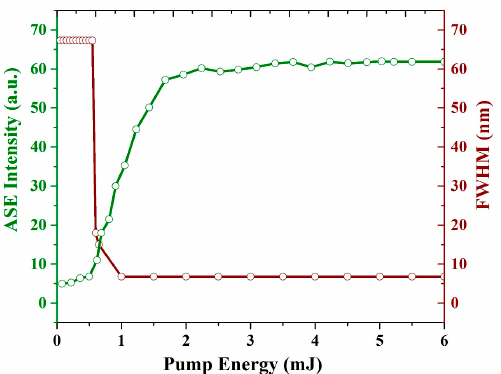
Figure 11. Relationship between the pump energy, intensity, and FWHM of the ASE of the CO film with a thickness of 380 nm and a concentration of 15 mg/mL. The green line indicates the ASE intensity (a.u.) and brown line indicates FWHM (nm).